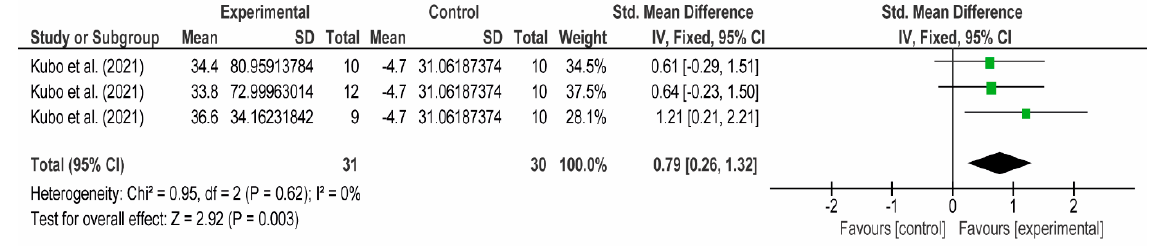
Figure 4. The effect size of 10-weeks of resistance training on increasing the pectoralis major MV. The Figure 4. The effect size of 10 -weeks of resistance training on increasing the pectoralis major MV. Figure 4. The effect size of 10 -weeks of resistance training on increasing the pectoralis major MV. Figure 4. The effect size of 10 -weeks of resistance training on increasing the pectoralis major MV. The lines respectively correspond to 4RM, 8RM and 12RM training groups. lines respectively correspond to 4RM, 8RM and 12RM training groups. The lines respectively correspond to 4RM, 8RM and 12RM training groups. The lines respectively correspond to 4RM, 8RM and 12RM training groups.